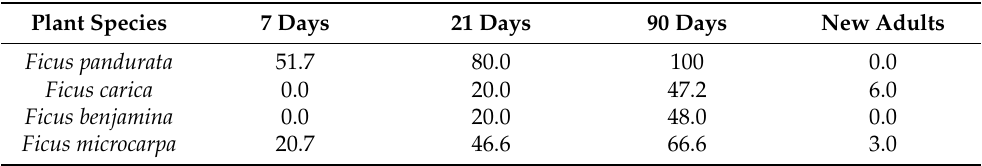
Table 5. Mortality (%) after 7, 21, and 90 days, and new adults’ emergence of Aclees taiwanensis on different Ficus